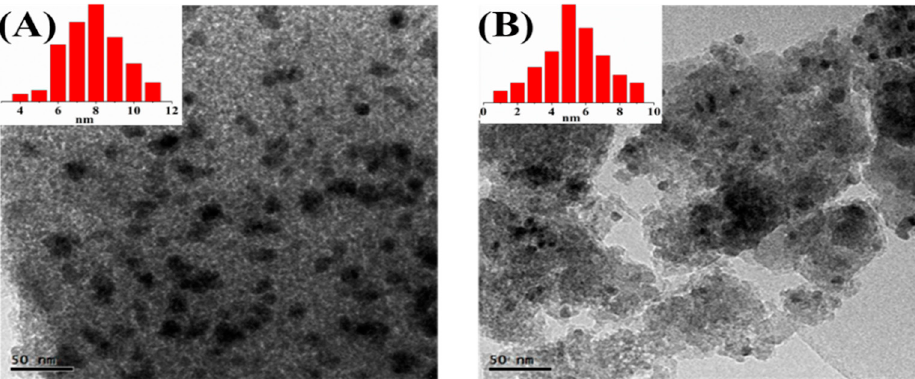
Figure 2. TEM images with the corresponding Cu particles size distribution diagrams of reduced ( A ) Cu/SiO 2 and ( B ) 2B-Cu/SiO 2 catalysts.